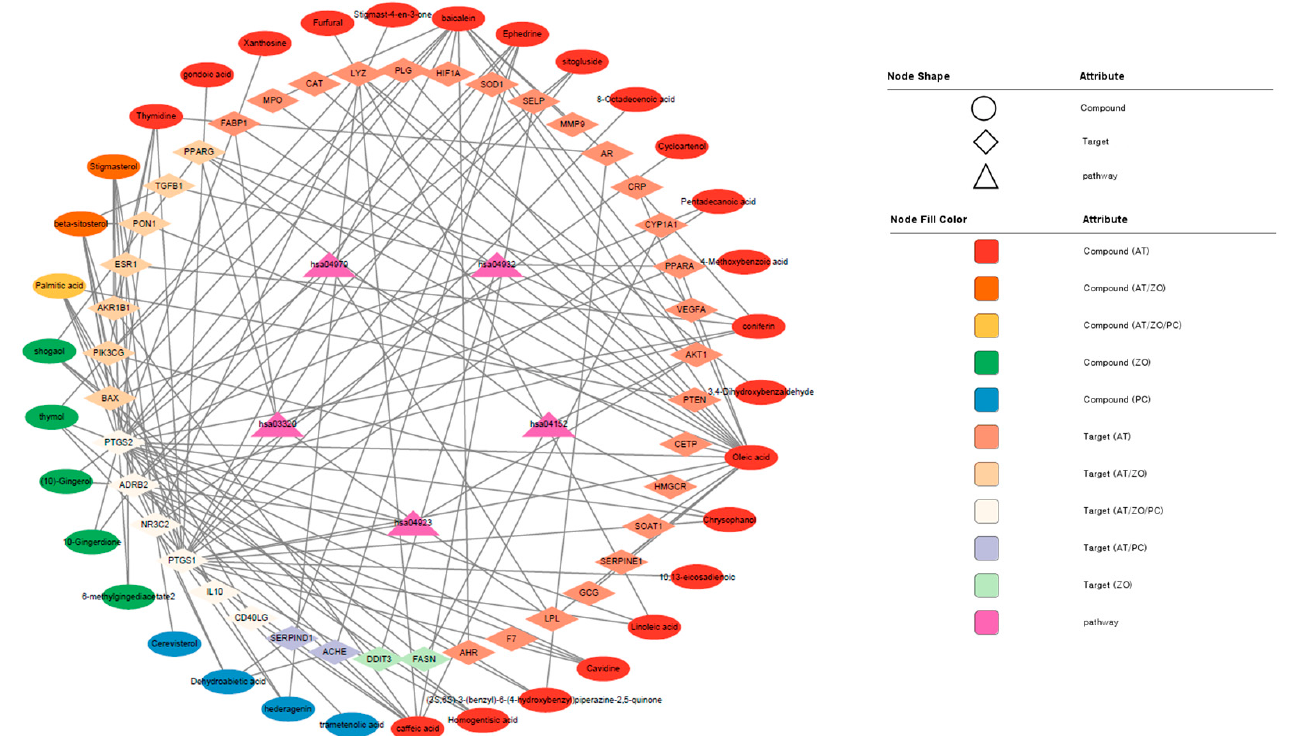
Figure 3. Visualization of the compounds–targets–pathways network constructed with the components of the herbal combination. Table 3. Enriched KEGG pathway obtained from DAVID database.